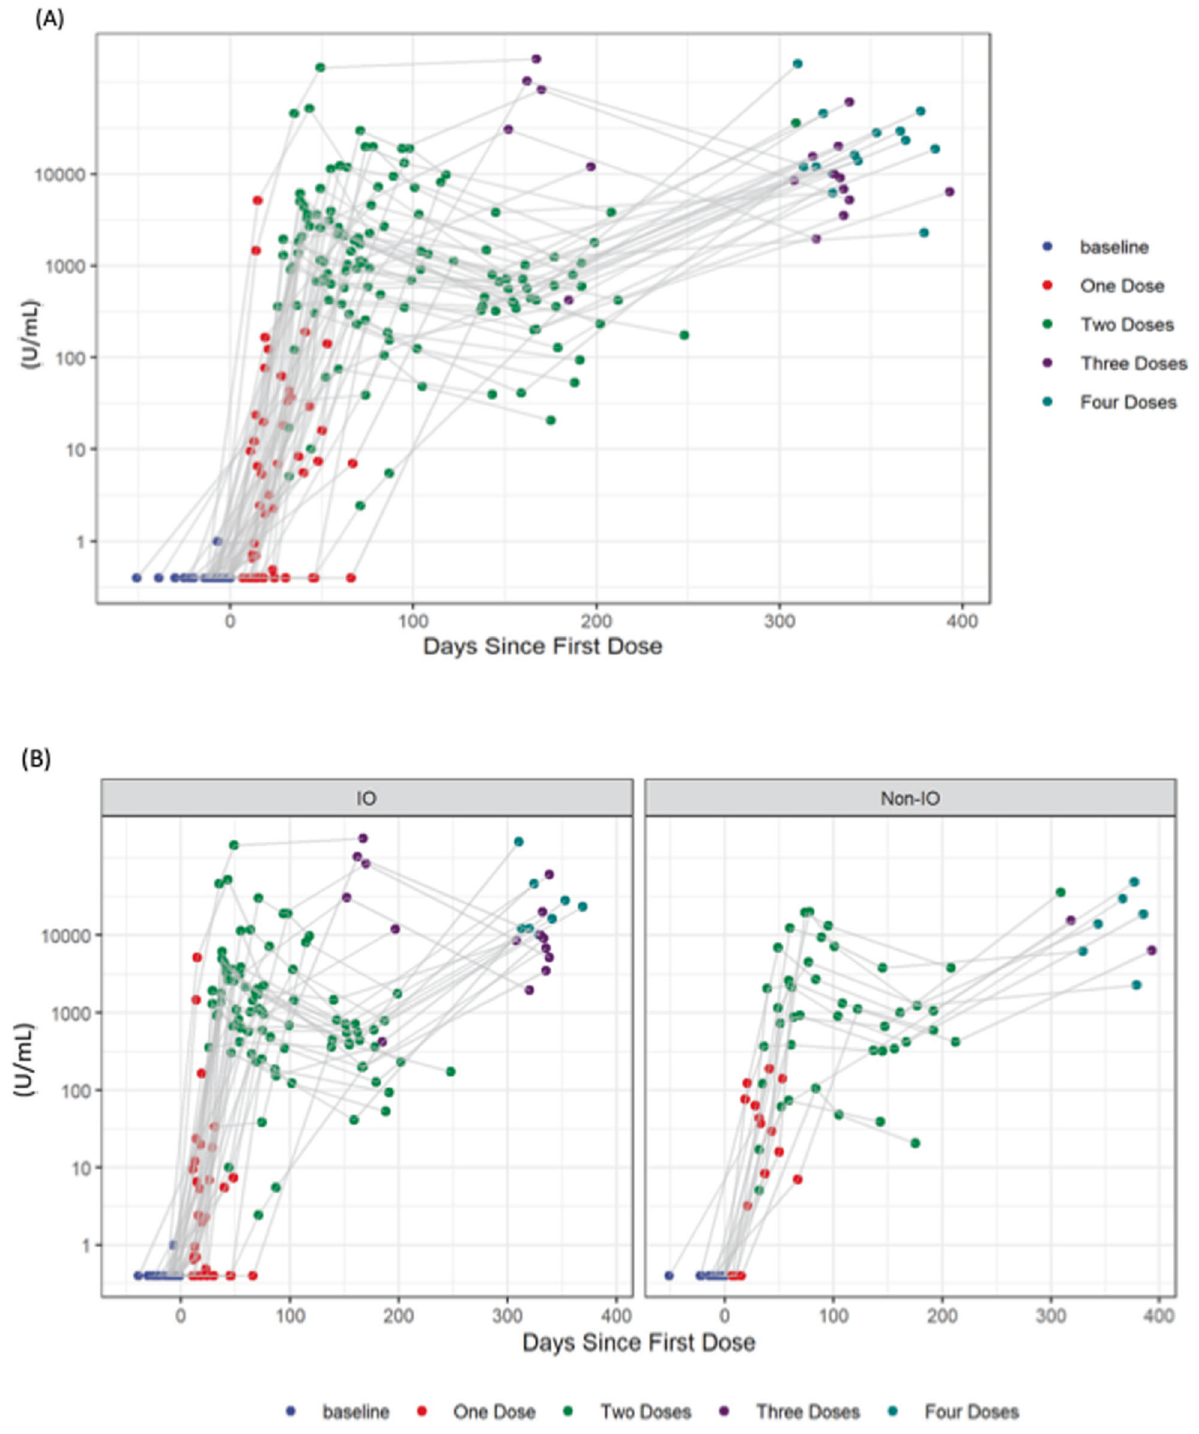
Fig. 1 Antibody level dynamics over time. A Anti-RBD antibody levels for all patients in relation to time; colours indicate numbers of vaccine doses (1 dose: red; 2 doses: green; 3 doses: purple, 4 doses: light blue). B anti-RBD antibody levels for all patients in relation to time strati fi ed into those treated with immunotherapy (IO) and non-immunotherapy (non-IO).